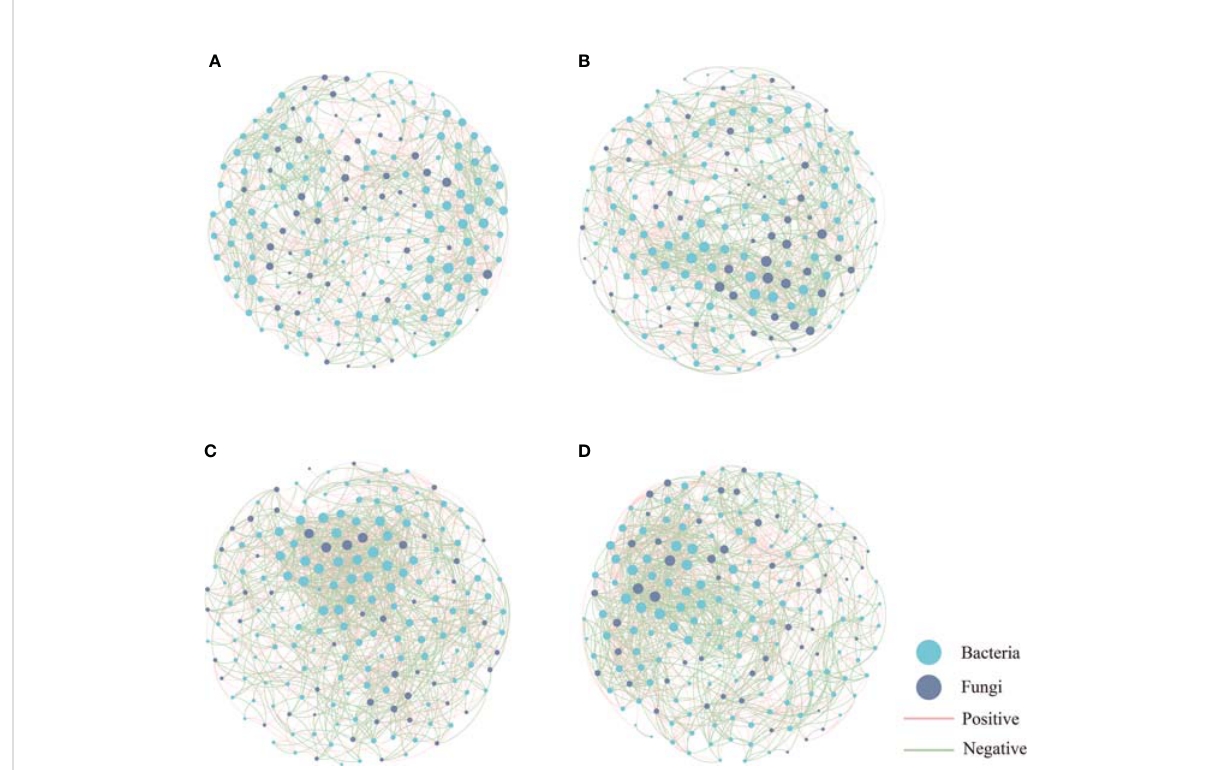
FIGURE 6 Network plots of bacterial and fungal communities in CK (A) , OF (B) , CF (C) and BF (D) , CK is untreated control; CF is chemical fertilizer; OF is organic fertilizer; BF is bioorganic fertilizer. Blue nodes indicate bacteria; gray nodes indicate fungi; red lines between nodes indicate positive interaction; and green lines indicate negative